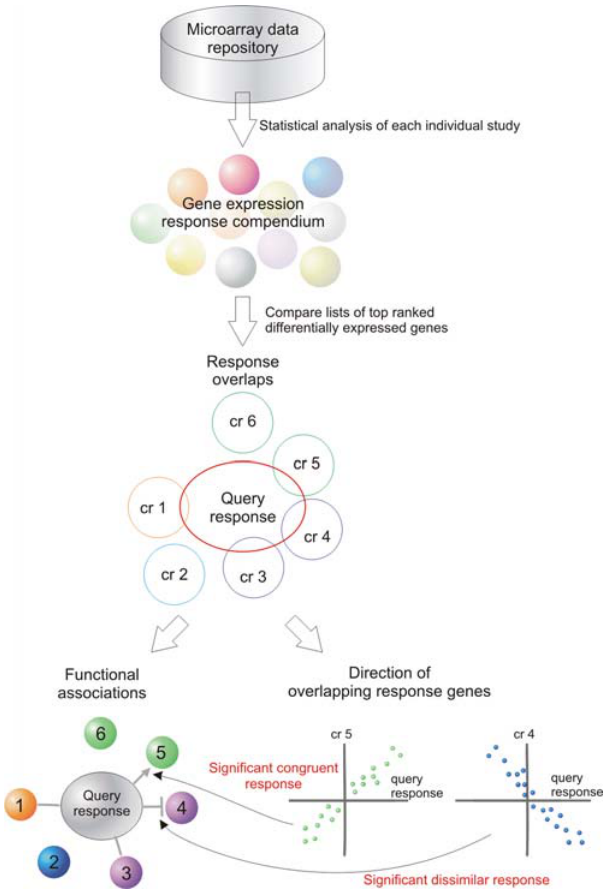
Figure 1. Overview of the FARO method. A large number of gene expression studies from a microarray data repository are analyzed individually, resulting in a compendium of gene expression responses. Each of these responses corresponds to a list of top ranking, differentially expressed genes. A query response, for example a response measured in a new microarray experiment, may then be compared to the compendium responses (cr) and the response overlap in terms of common, differentially expressed genes determined. The strength of an association is determined by the size of the overlap and the result illustrated in a FARO map (bottom right and Figure 2). In the example, the query response demonstrates significant associations to compen- dium factors 1, 3, 4, and 5. Moreover, it is possible to test if the direction of a response is predominantly dissimilar (factor 4) or congruent (factor 5). This is indicated in the FARO map by a hammerhead or an arrow, respectively.